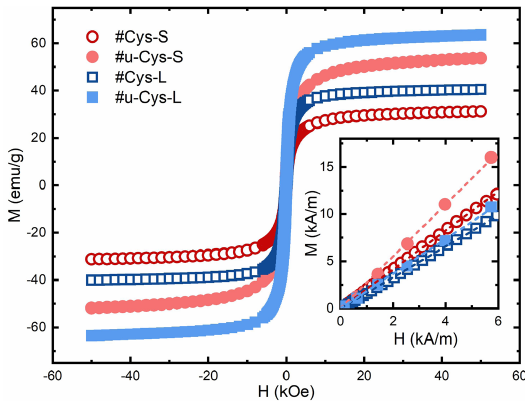
Figure 2. Room temperature magnetization curves of studied samples. Inset shows a magnification of the low field are, enhancing the visualization of the low field magnetic susceptibilities.